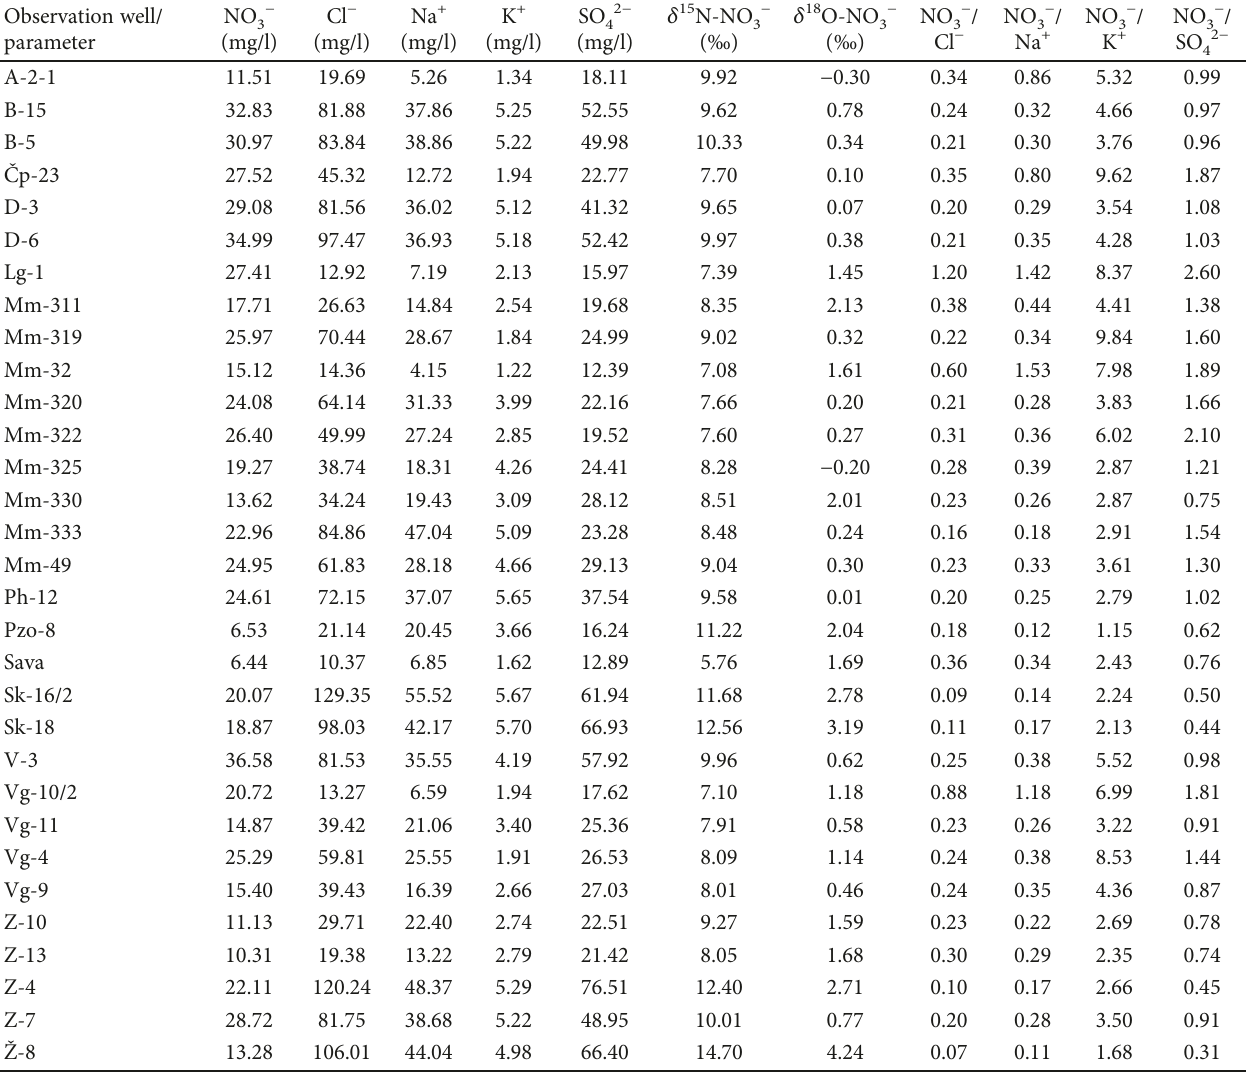
Table 3: Average values of parameters at observation wells.